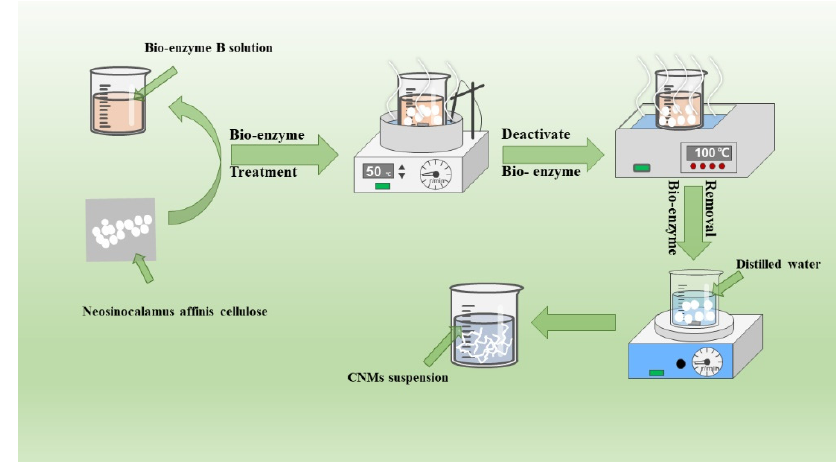
Figure 2. Flowchart of preparing